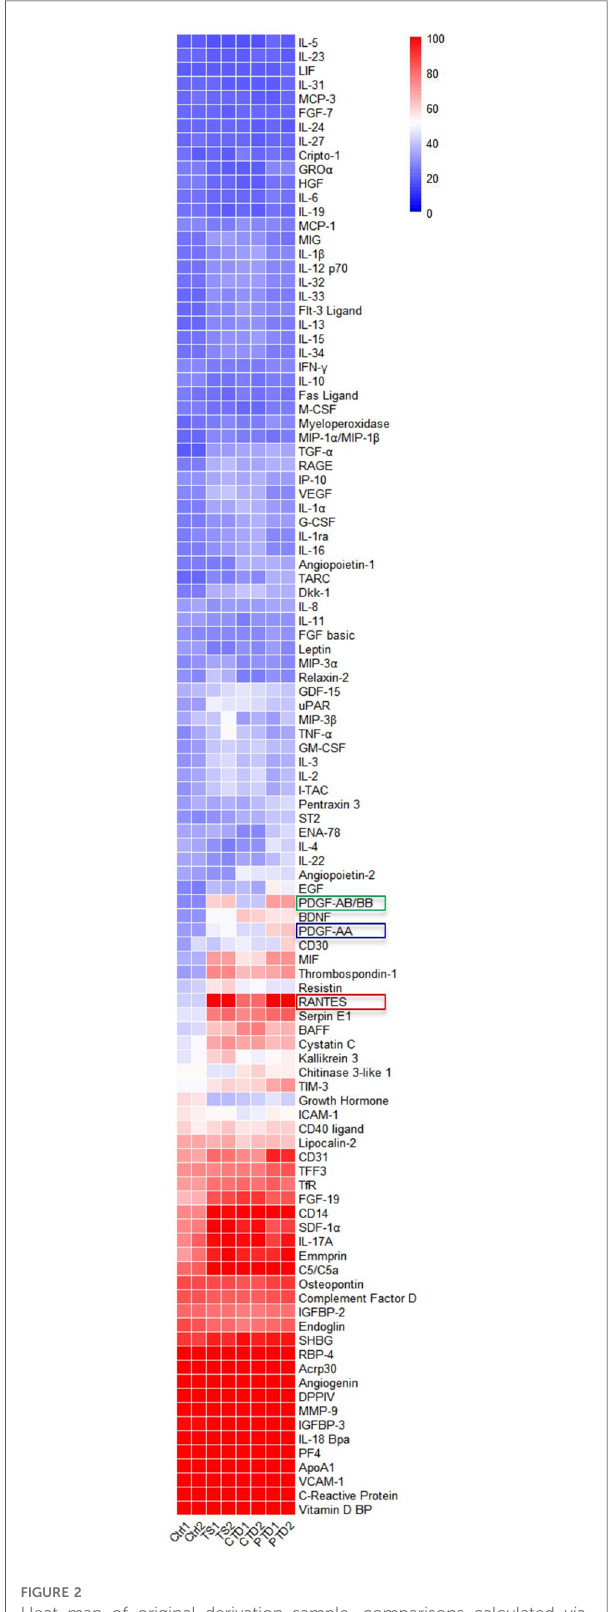
FIGURE 2 Heat map of original derivation sample, comparisons calculated via 1-normal, 2-TS, 3-CTD, 4-PTD. The red, blue, and green boxes are marked with cytokines that differ signi fi